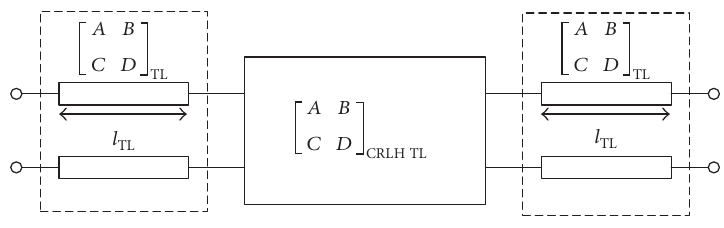
Figure 4: Immittances characteristics of T-type equivalent circuit model. (a) Series impedance 𝑍 𝑌 characteristic curve. sh